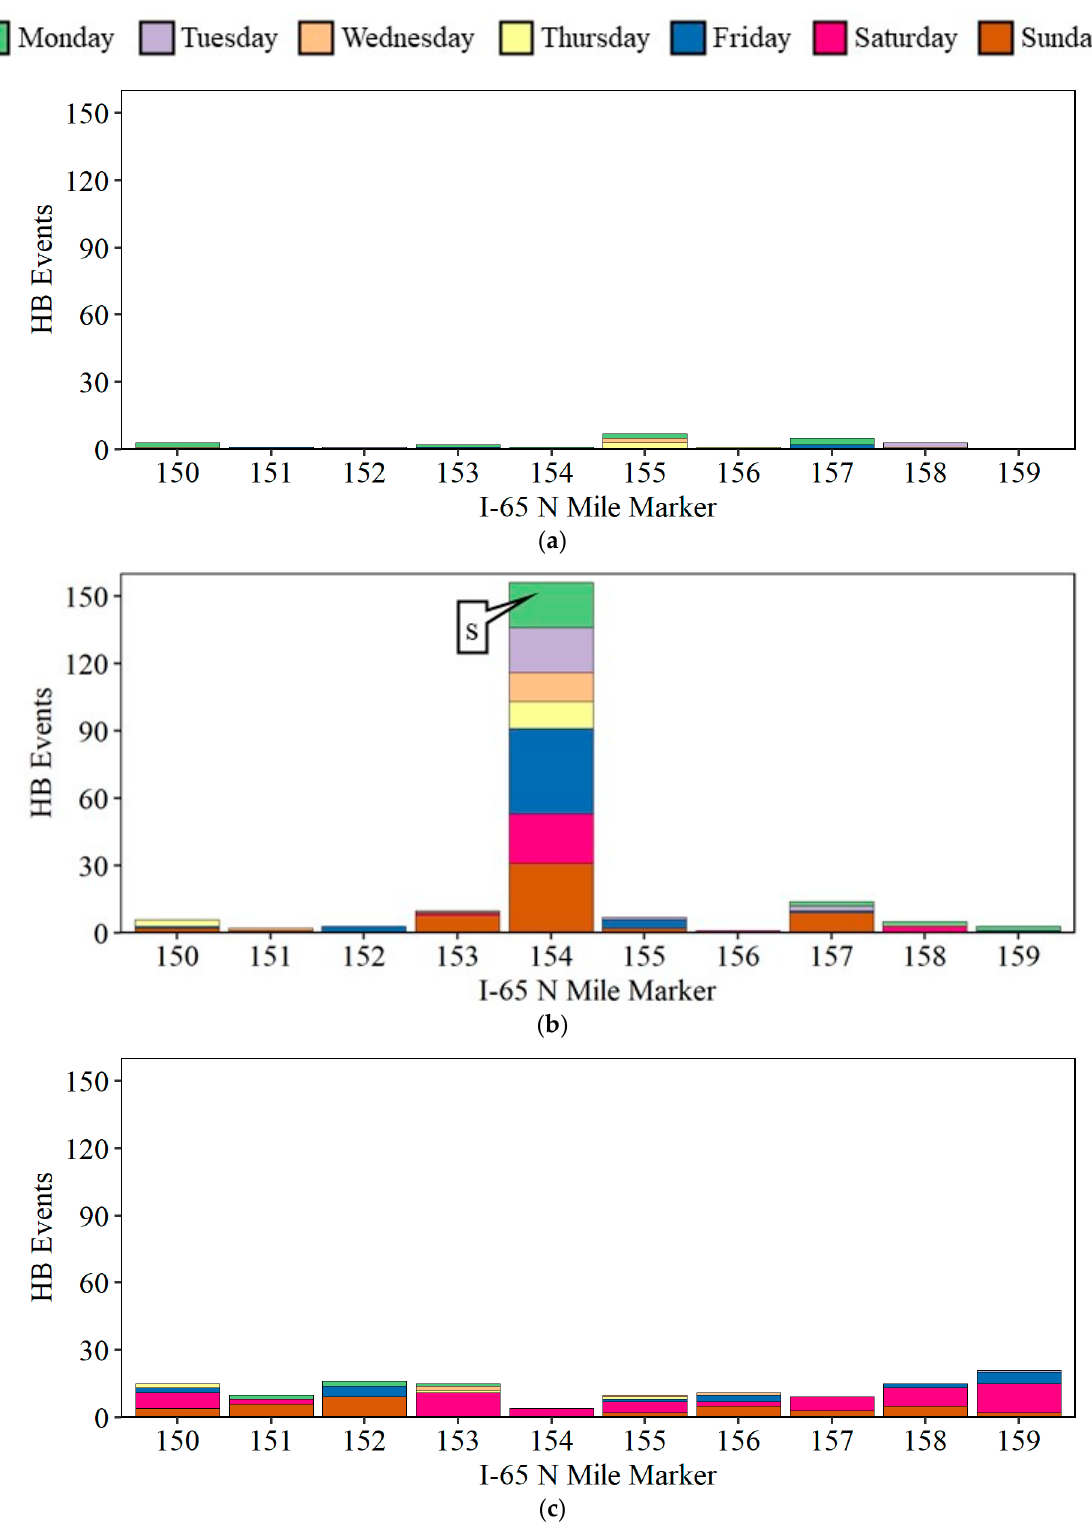
Figure 17. Hard-braking events by 1 mile-segments along I-65 NB between MM 150 and MM 160.